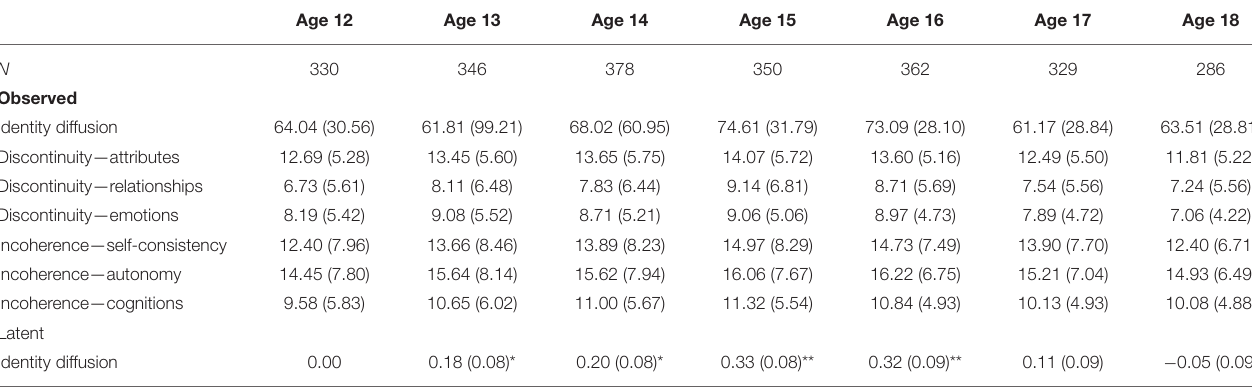
TABLE 2 | Descriptive statistics by age group for observed and latent variables of identity